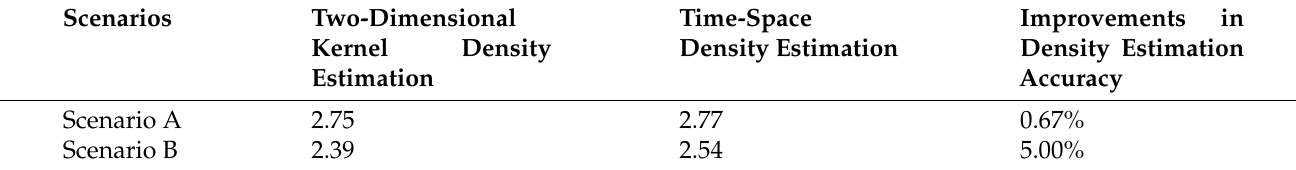
Table 3. Simulation results for density estimation under different sampling scenarios.